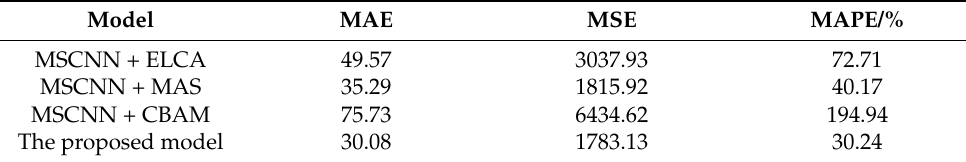
Table 4. Experimental results of adding white Gaussian noise to vibration signals.